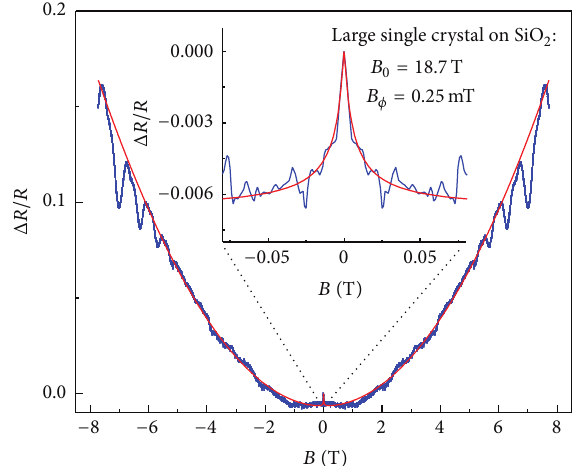
Figure 7: The measured symmetrized magnetoresistance (𝑅 𝑥𝑥 (𝐵) + (−𝐵)) of a large single crystal graphene sample on SiO 𝑅 𝑥𝑥 measured at 𝑉 𝐺 = +80 V (blue dots) and at 0.3 K. The relative resistance and the fit (red line) using (19) with fitting parameters = 0.25 mT, 𝐿 /𝐿 = 0.0067 , 𝐵 = 18.7 T, and 𝐵 𝐵 𝑐𝜙 𝜙 𝑐 0